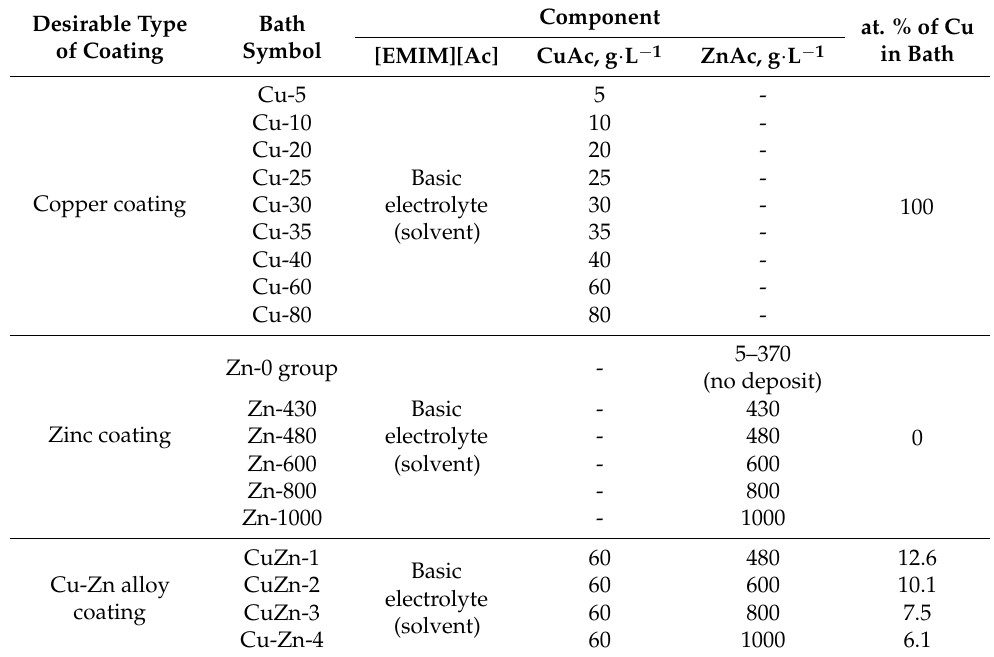
Table 1. Chemical composition of the galvanic baths for Cu, Zn, Cu-Zn coatings